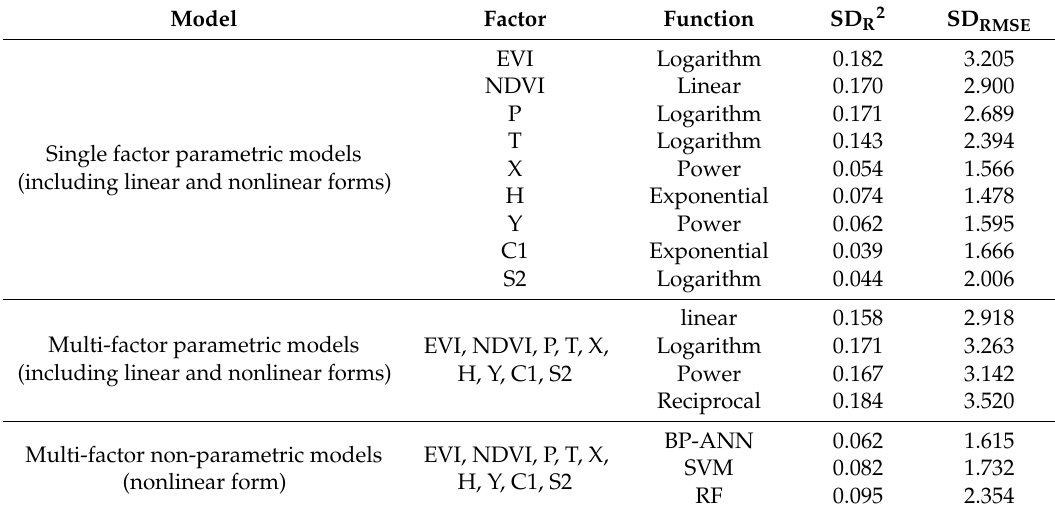
Table 9. Performance of different models in the prediction of grassland